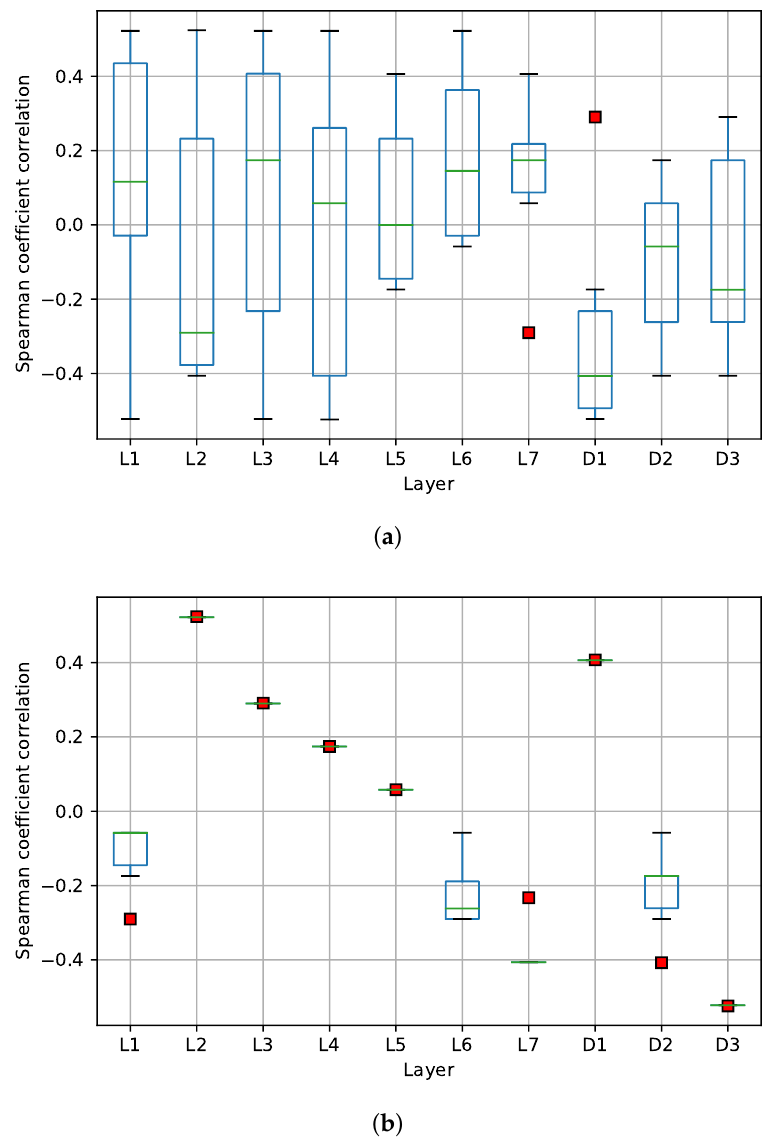
Figure 6. Spearman’s correlation per layer. Panel ( a ) shows the accuracy and Panel ( b ) shows the NICS against each quantized CNN layer. Note that a correlation is negligible when ρ < | 0.1 | , low when | 0.1 | < ρ < = | 0.3 | , medium when | 0.3 | < ρ < = | 0.5 | , and strong or high when ρ > | 0.5 |